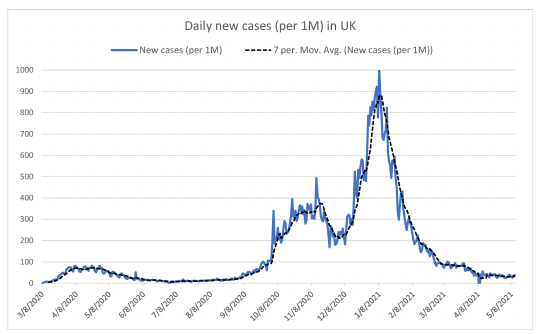
The COVID-19 data for the UK over the time horizon of April 2020 – May 2021 is taken from the reliable web-based source [27]. The given function I ( t ) corresponds to the column “Daily new confirmed COVID-19 cases per million people” and is shown in Figure 2.